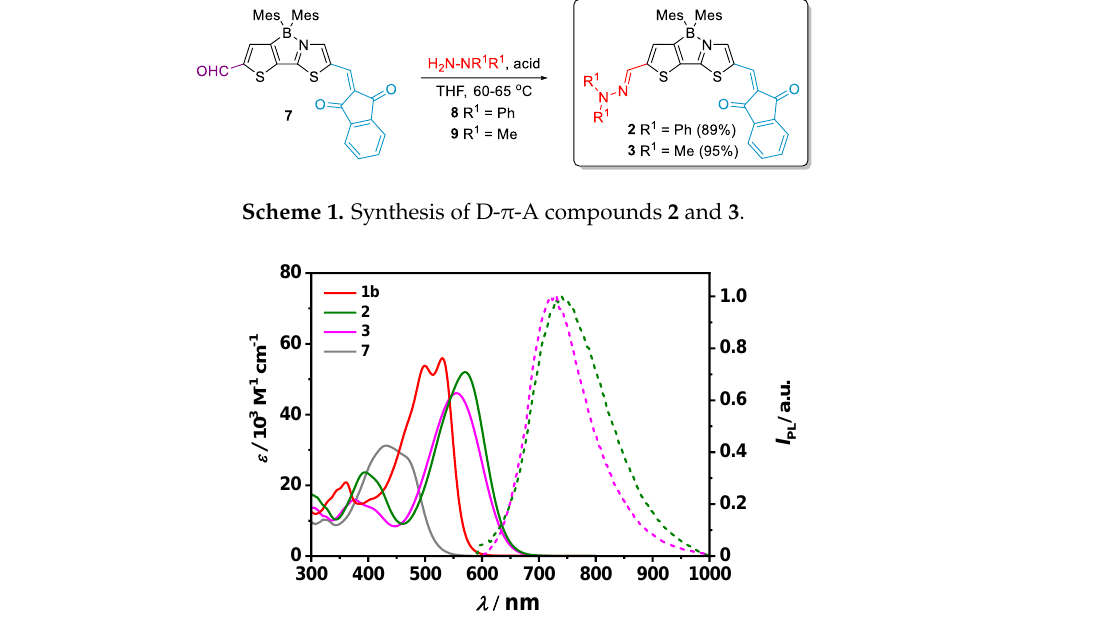
Figure 2. UV/Vis absorption spectra of dyes 2 , 3 , 7 , and 1b (solid lines) measured at c ~ 10 − 5 M in CH 2 Cl 2 and fluorescence spectra of 2 and 3 (dashed lines) determined in CH 2 Cl 2 by optical dilution method (OD < 0.05). Table 1. Optical and electrochemical properties of dyes 2 , 3 , 7 and reference compound 1b